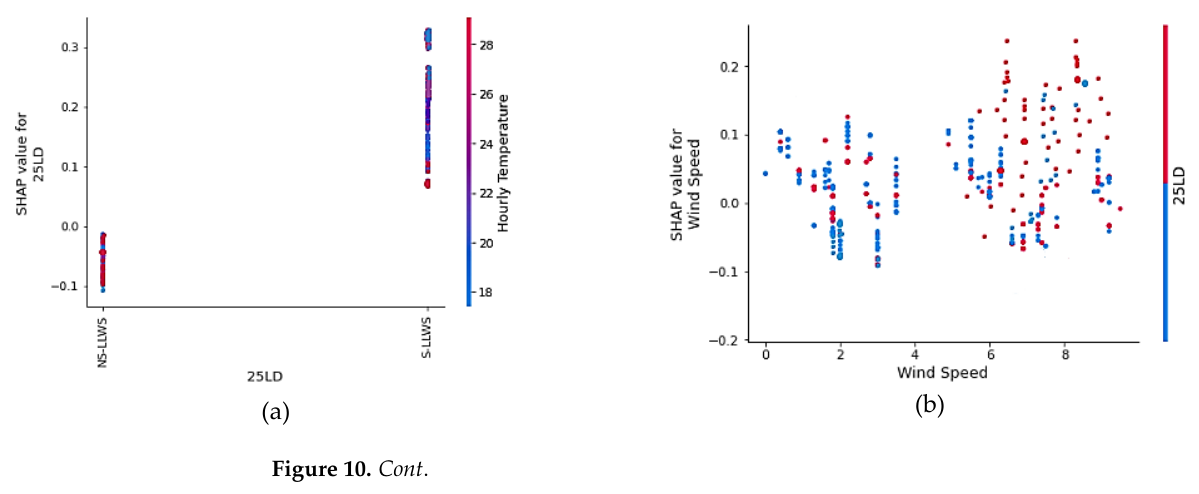
Figure 9. SHAP Explanatory Force Pot: ( a ) Plot for an instance value equals to 1.03; ( b ) Plot for an instance value equals to 0.52.